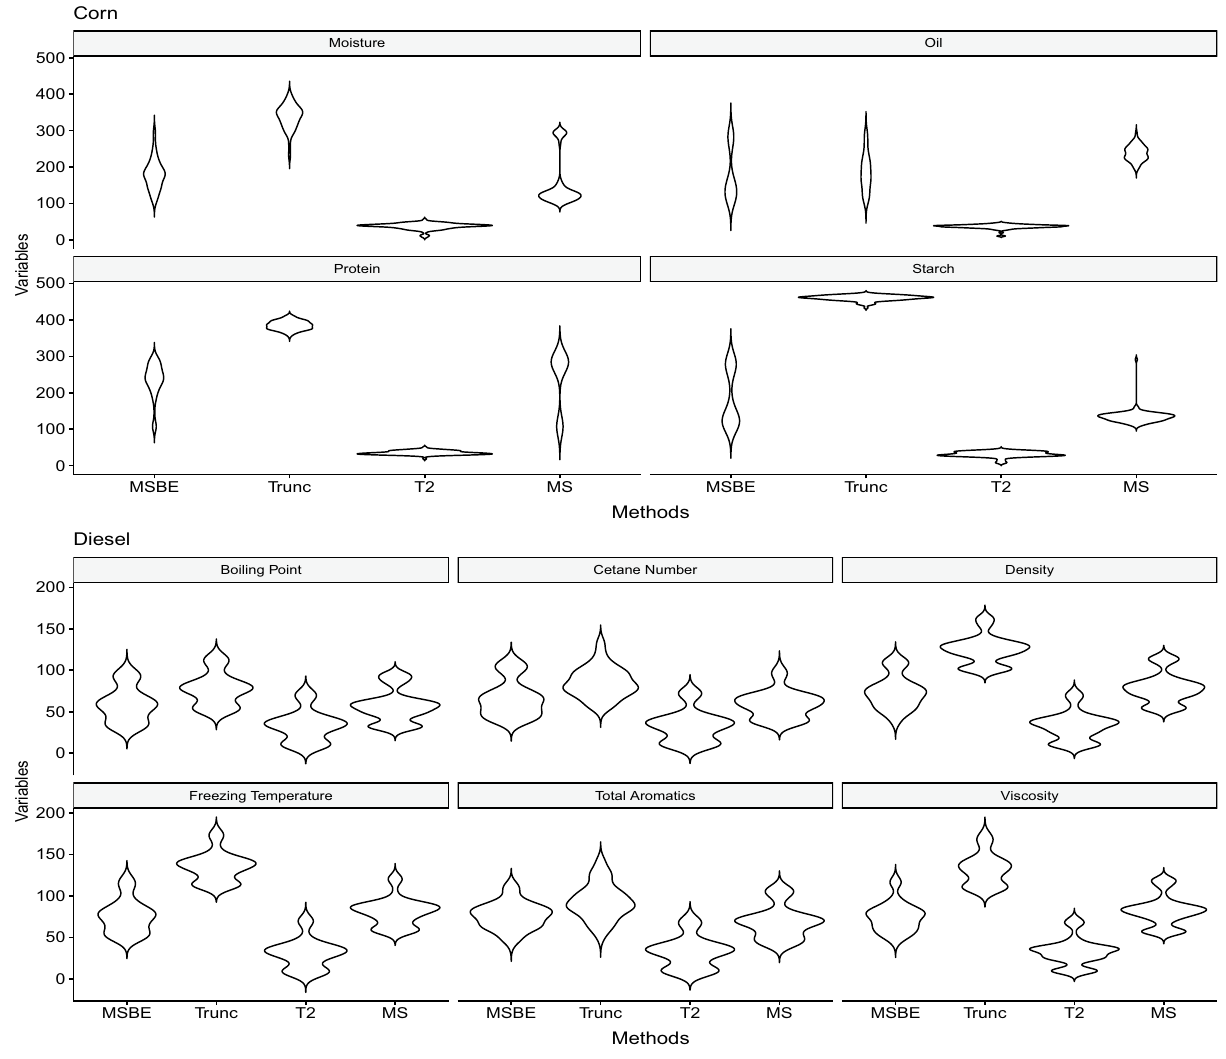
Figure 7. The distribution of number of selected variables i.e. wavenumbers is presented for all fitted corn and diesel contents models. Trends are extracted based on the 100 Monte Carlo